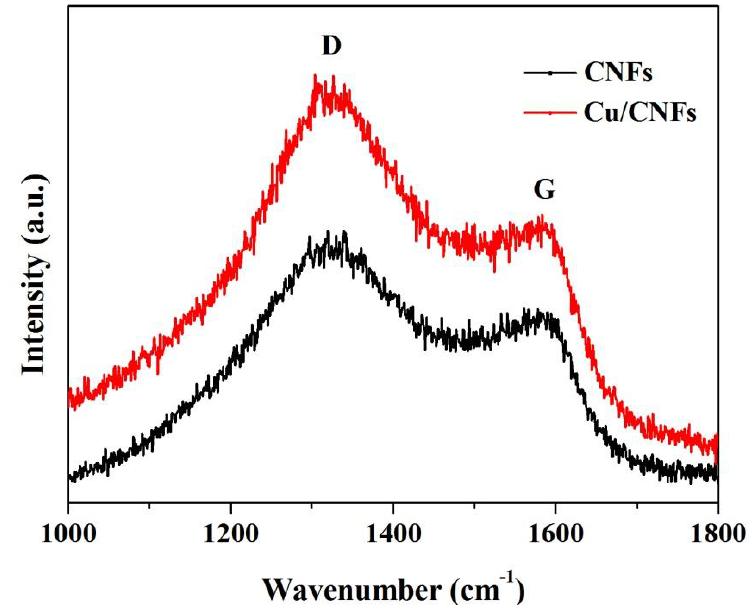
Figure 3. Raman spectrum of CNFs and